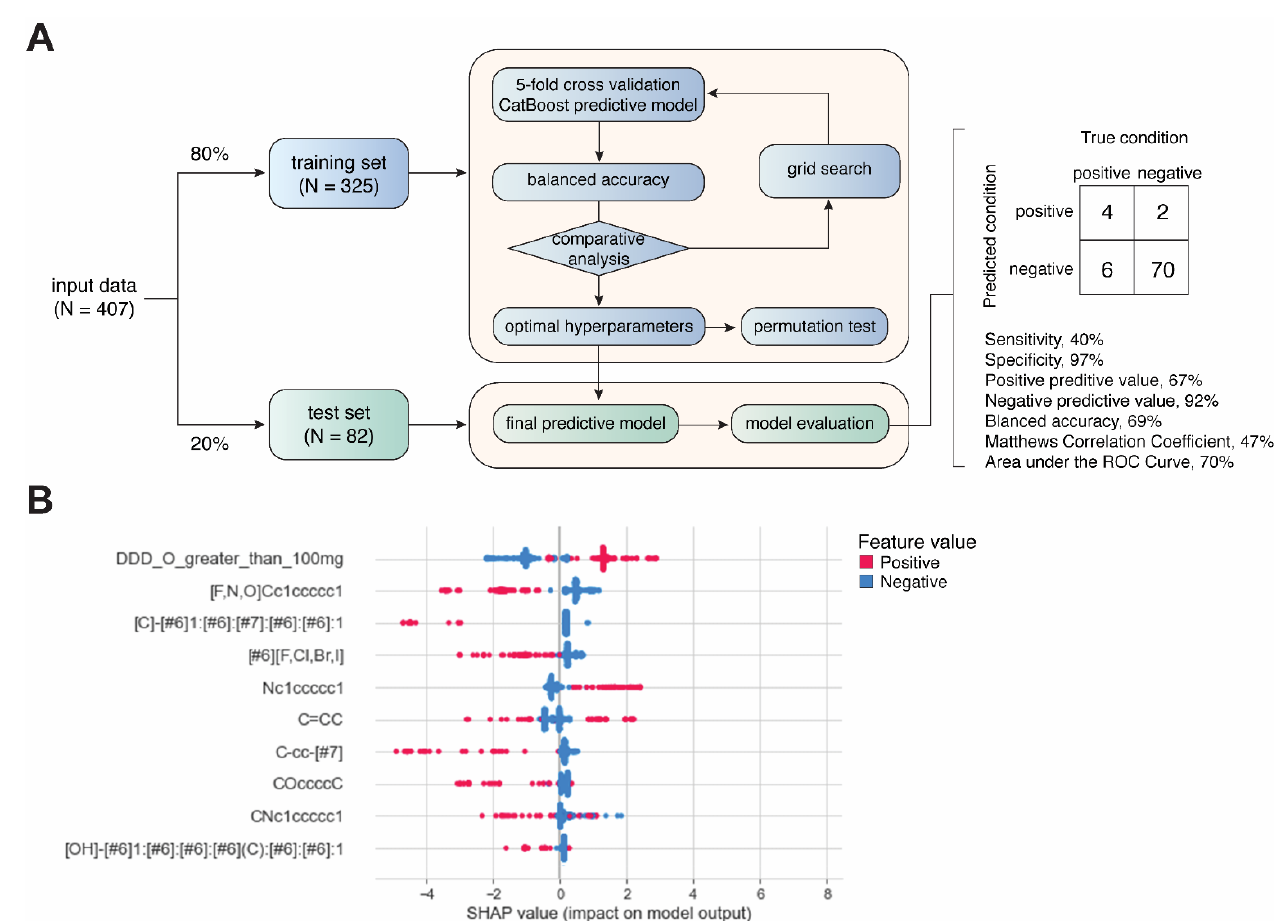
Figure 2. Development of machine-learning-based predictive model. ( A ) Workflow of model development. ( B ) Summary plot showing SHAP values and feature values for top 10 most important features.